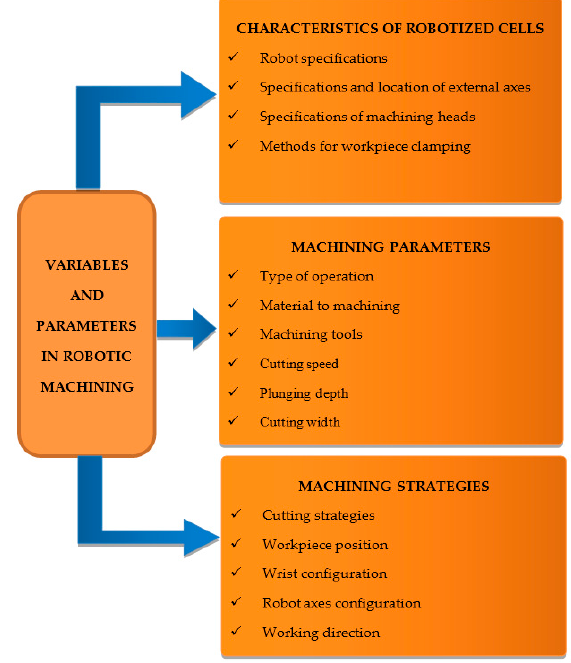
Figure 1. Diagram of variables and parameters in robot